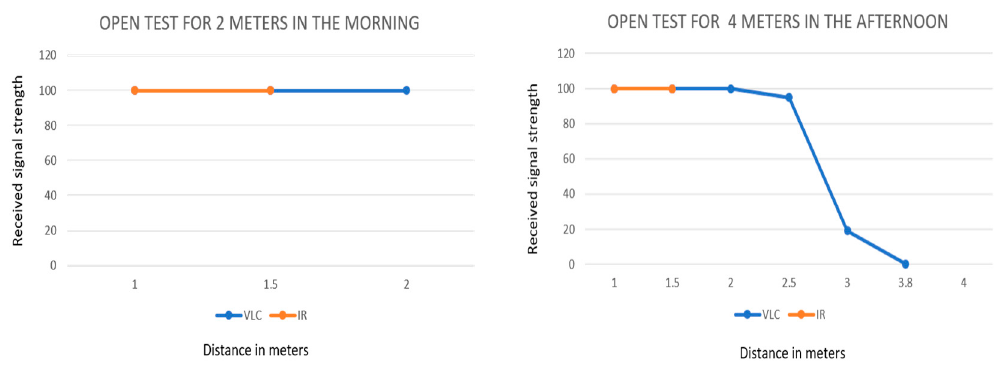
Figure 16. Open seabed test.